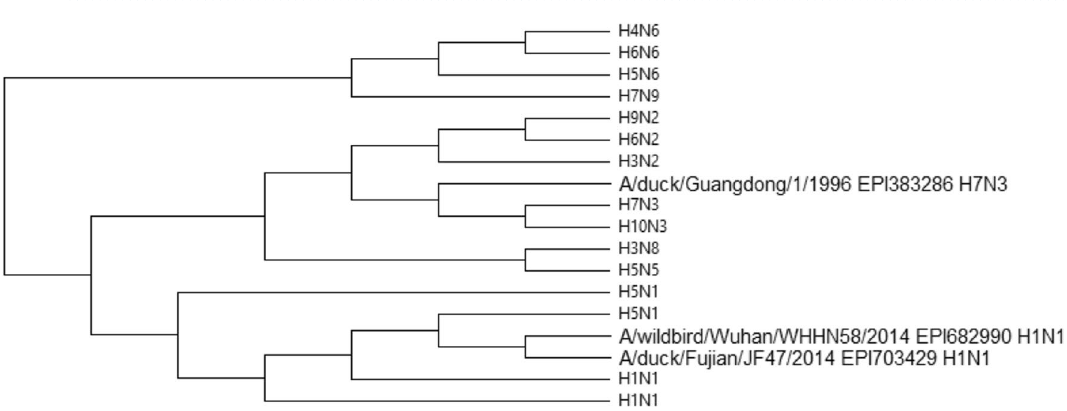
Figure 18. The phylogenetic tree of 1163 Influenza A viruses proteins constructed by our method